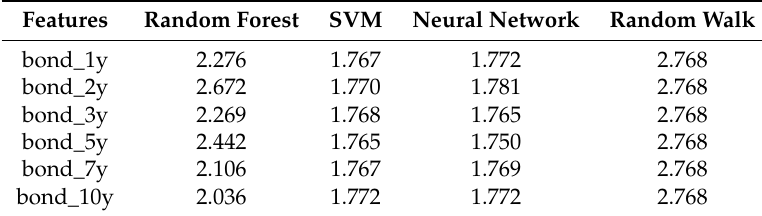
Table A1. Mean absolute percentage error (MAPE) of UIRP